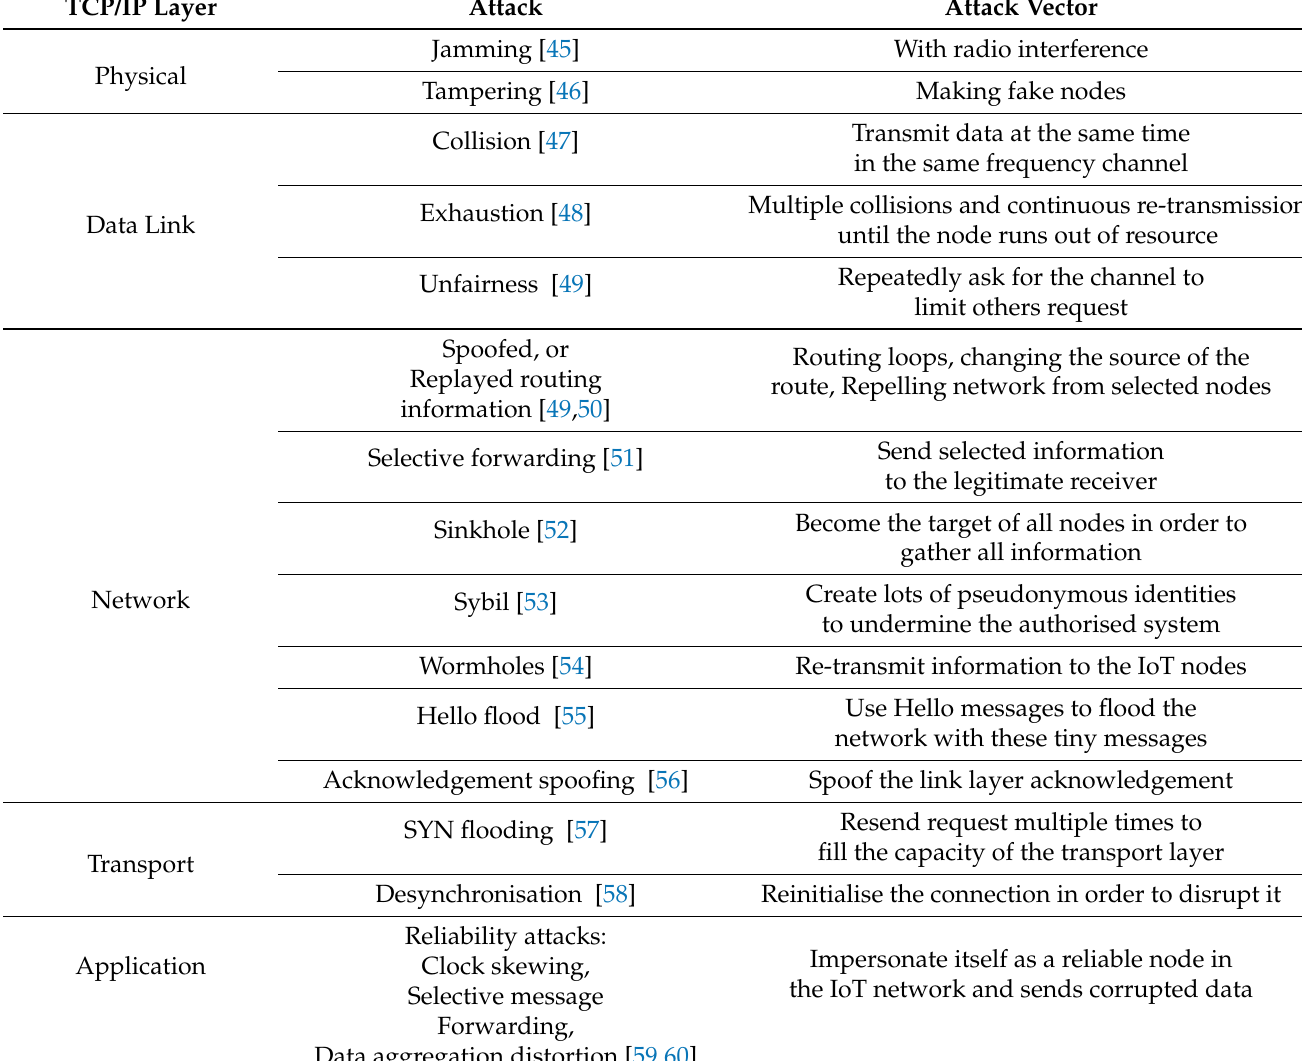
Table 1. Taxonomy of attacks based on different layers of the TCP/IP model in IoE domain [44]. TCP/IP